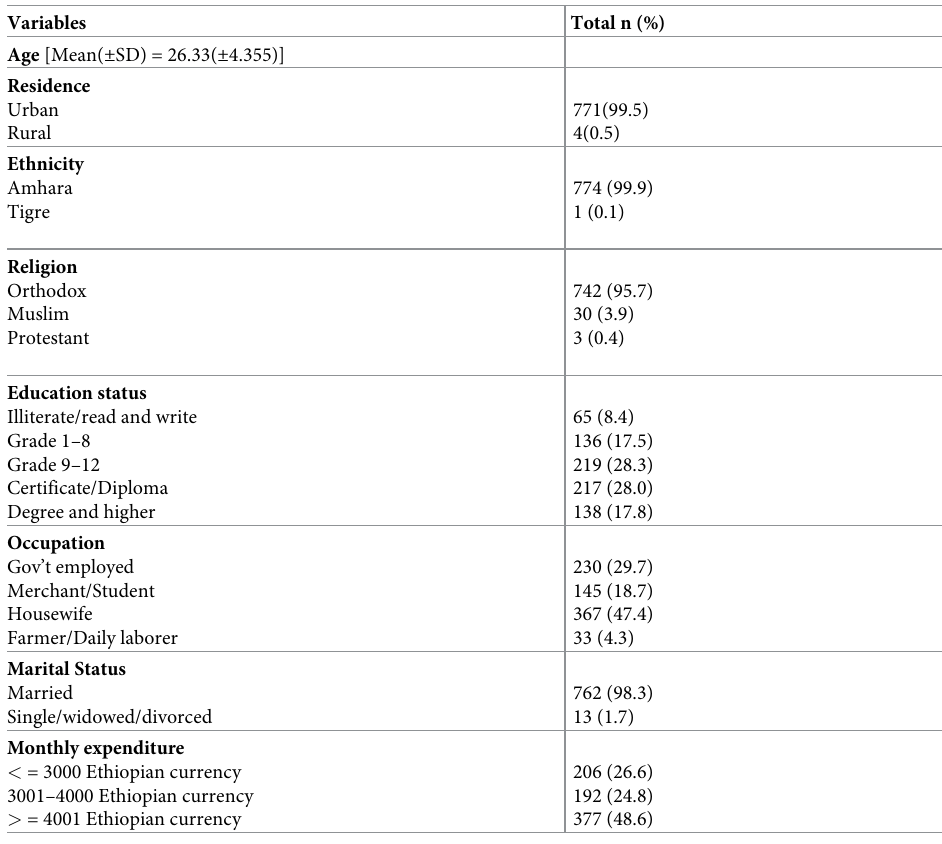
Table 1. Socio-demographic characteristics of postpartum women in Northwest Ethiopia,